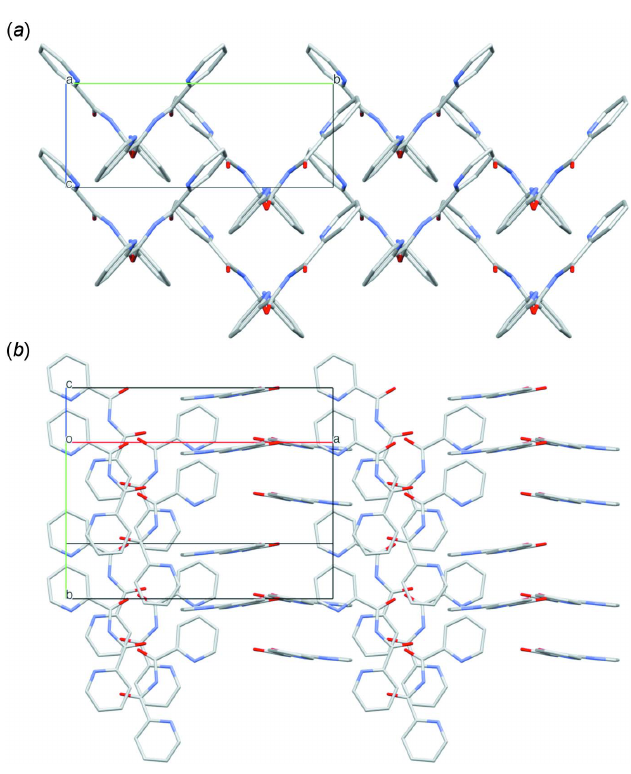
Figure 3 Packing in the structure of 1 , showing ( a ) the perpendicularly oriented molecules, viewed down the a axis and ( b ) the double layers of parallel- oriented (face-to-face) molecules, interchanged with analogous double layers, perpendicular to the former layers.